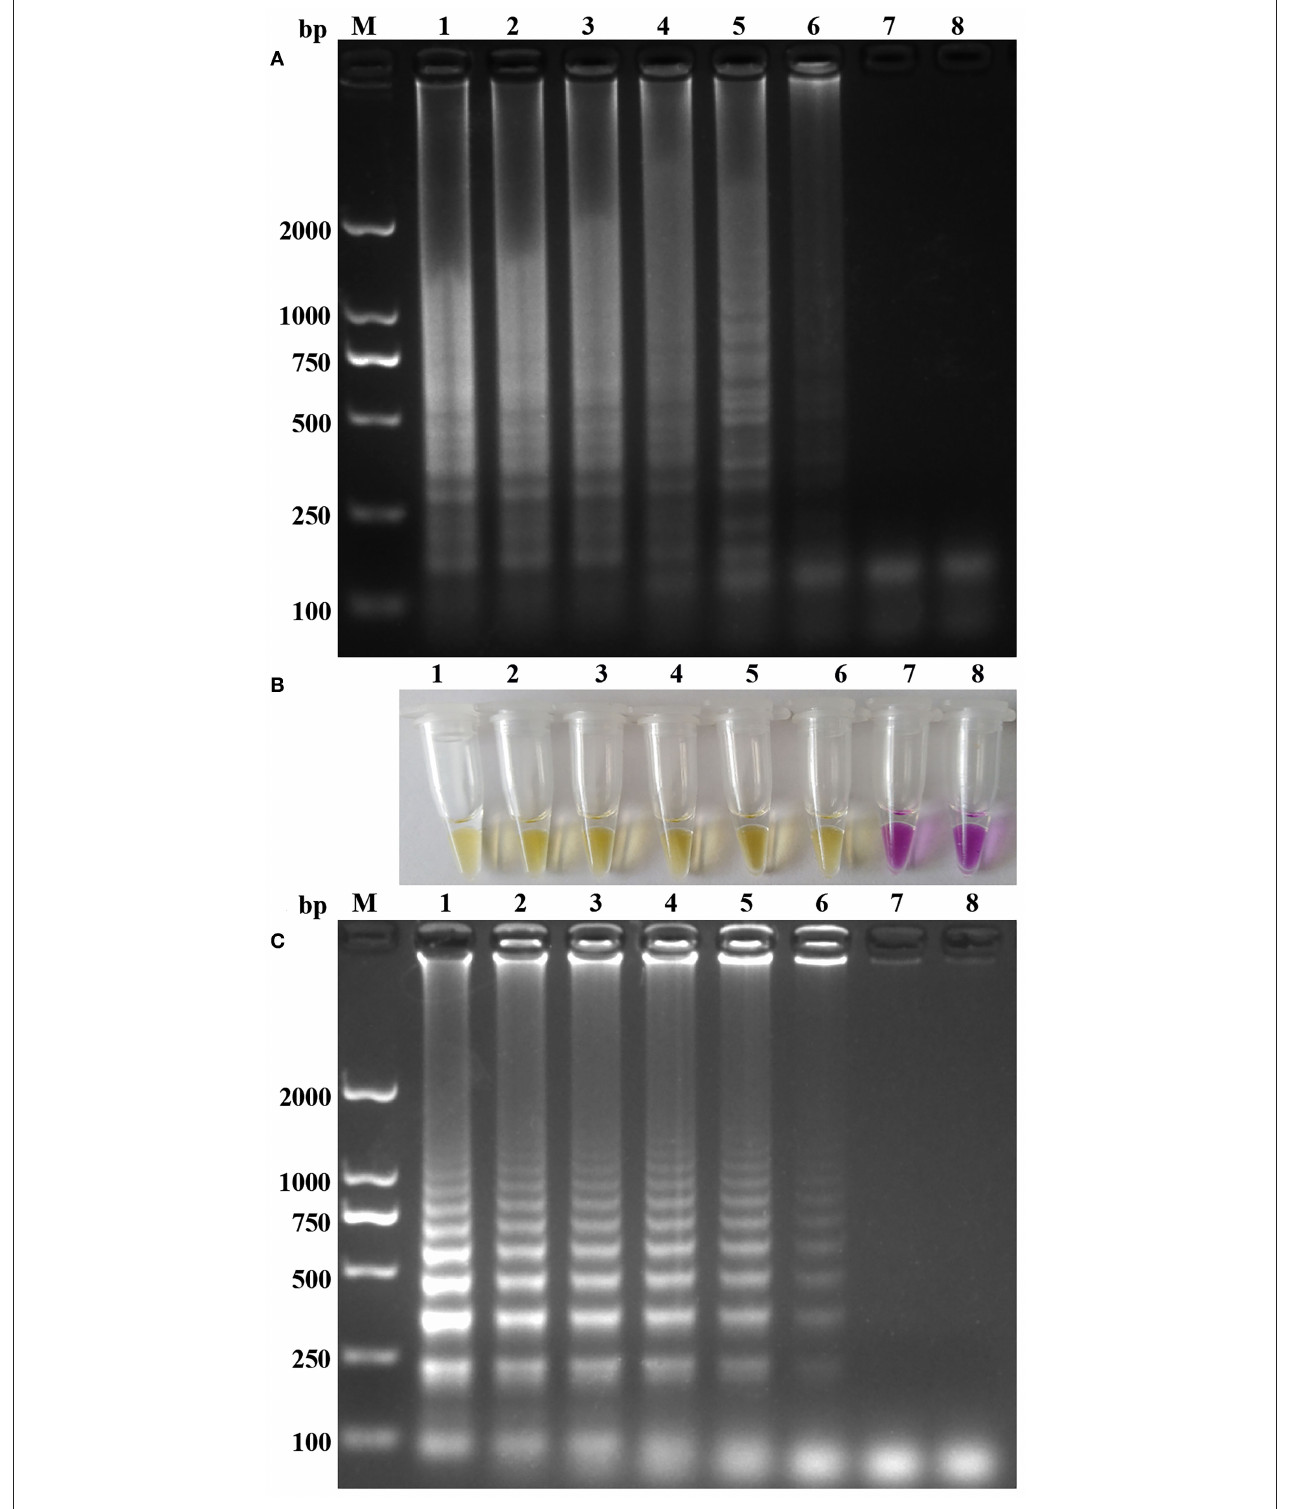
FIGURE 1 | Sensitivity of the one-step RT-PSR amplification for N-GoAstV: (A,C) Agarose gel electrophoresis of RT-PSR and RT-LAMP amplification products. (B) Visual detection of positive and negative RT-PSR amplification products. Lane M, molecular size marker DL2000; Lanes1-7, DNA template with 3.47 × 10 6 to 10 0 copies; Lane 8, negative